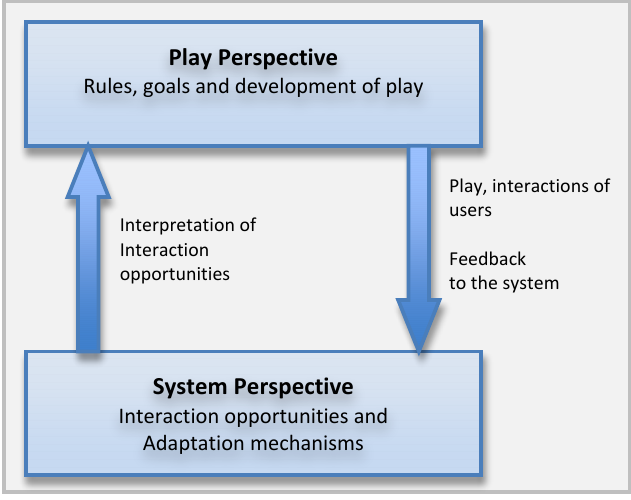
Figure 2. Perspectives on Inteligent play